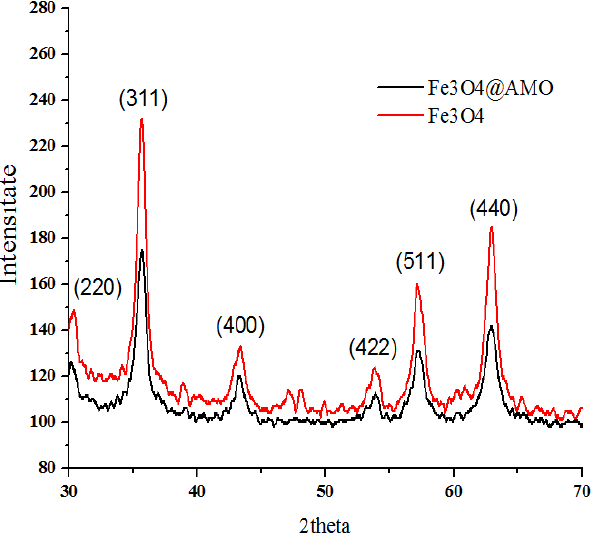
O @AMO and control Fe 3 4